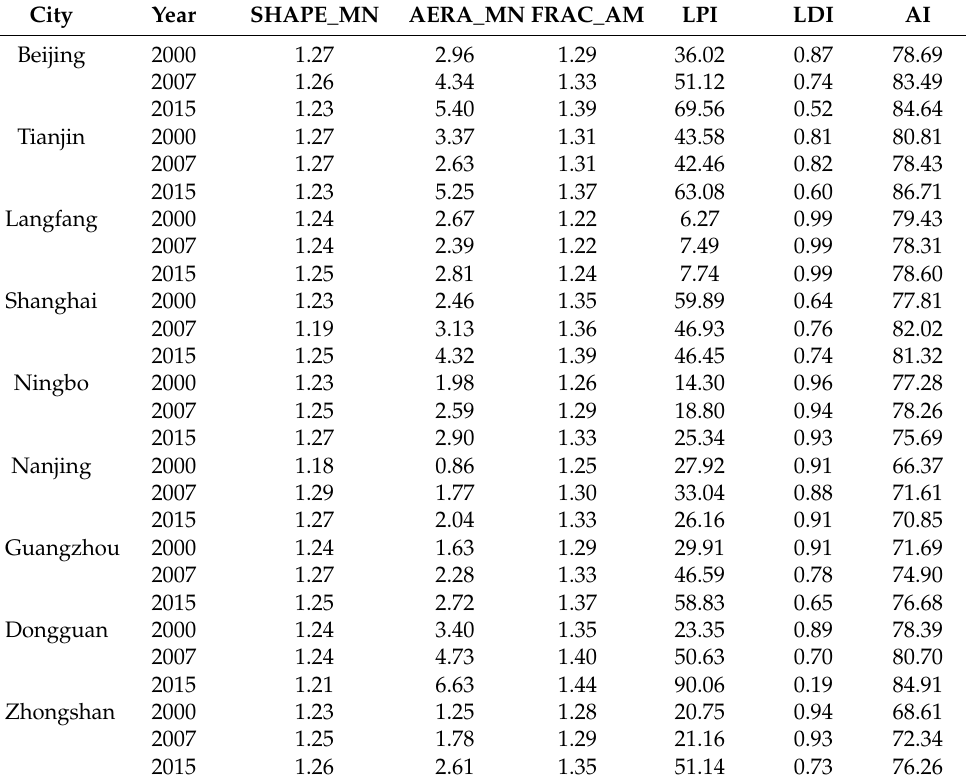
Table 2. Analysis results of the landscape configuration metrics of the ISA within different urban sizes and levels considered in this study. Meanings of these abbreviations of the variables can be referred to in Table